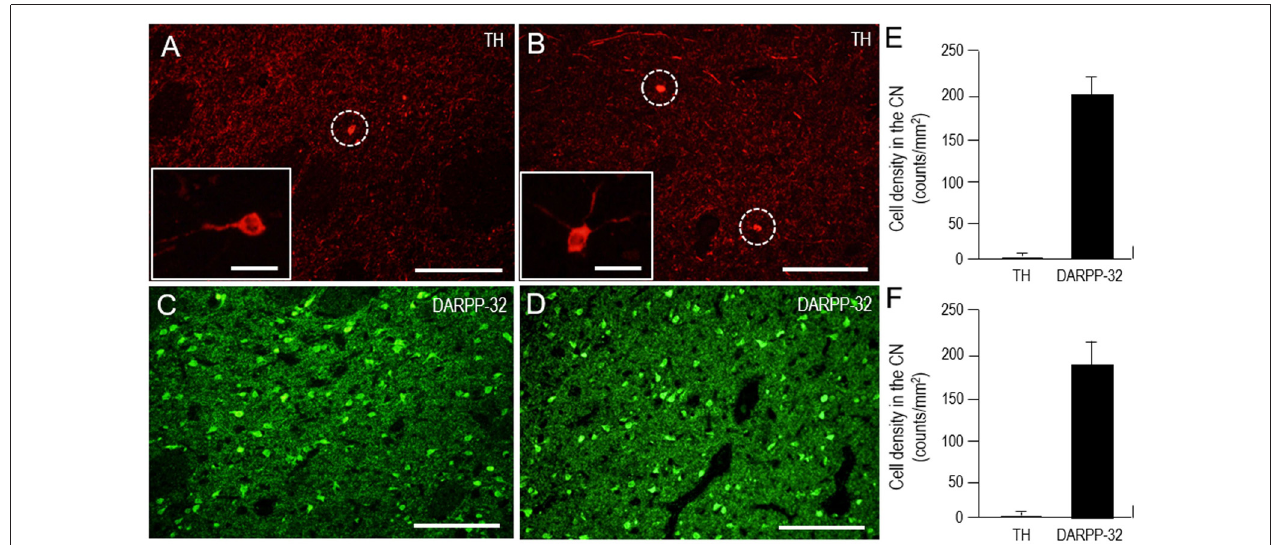
FIGURE 9 | Scarcity of TH-positive interneurons in the human neostriatum. (A–D) Photomicrographs of the CN (A,C) and putamen (B,D) stained for TH (A,B) and DARPP-32 (C,D) . The TH-positive cells are indicated by dashed open circles (A,B) . Higher-magnification images of the TH-positive cells are also shown in the insets in (A,B) . Scale bars: (A–D) 200 µ m, ( insets in A and B ) 20 µ m. (E,F) Cell density measurements of striatal cells positive for TH or dopamine and cAMP-regulated phosphoprotein of 32 kDa (DARPP-32) in the CN (E) and putamen (F) . Values are means ± SEM (bars), n = 25.